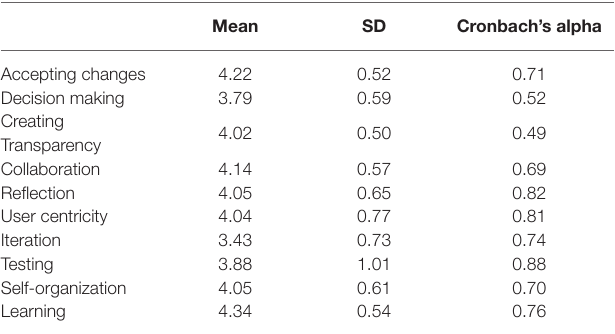
TABLE 5 | Means, standard deviations, and Cronbach’s alpha in sample 2.